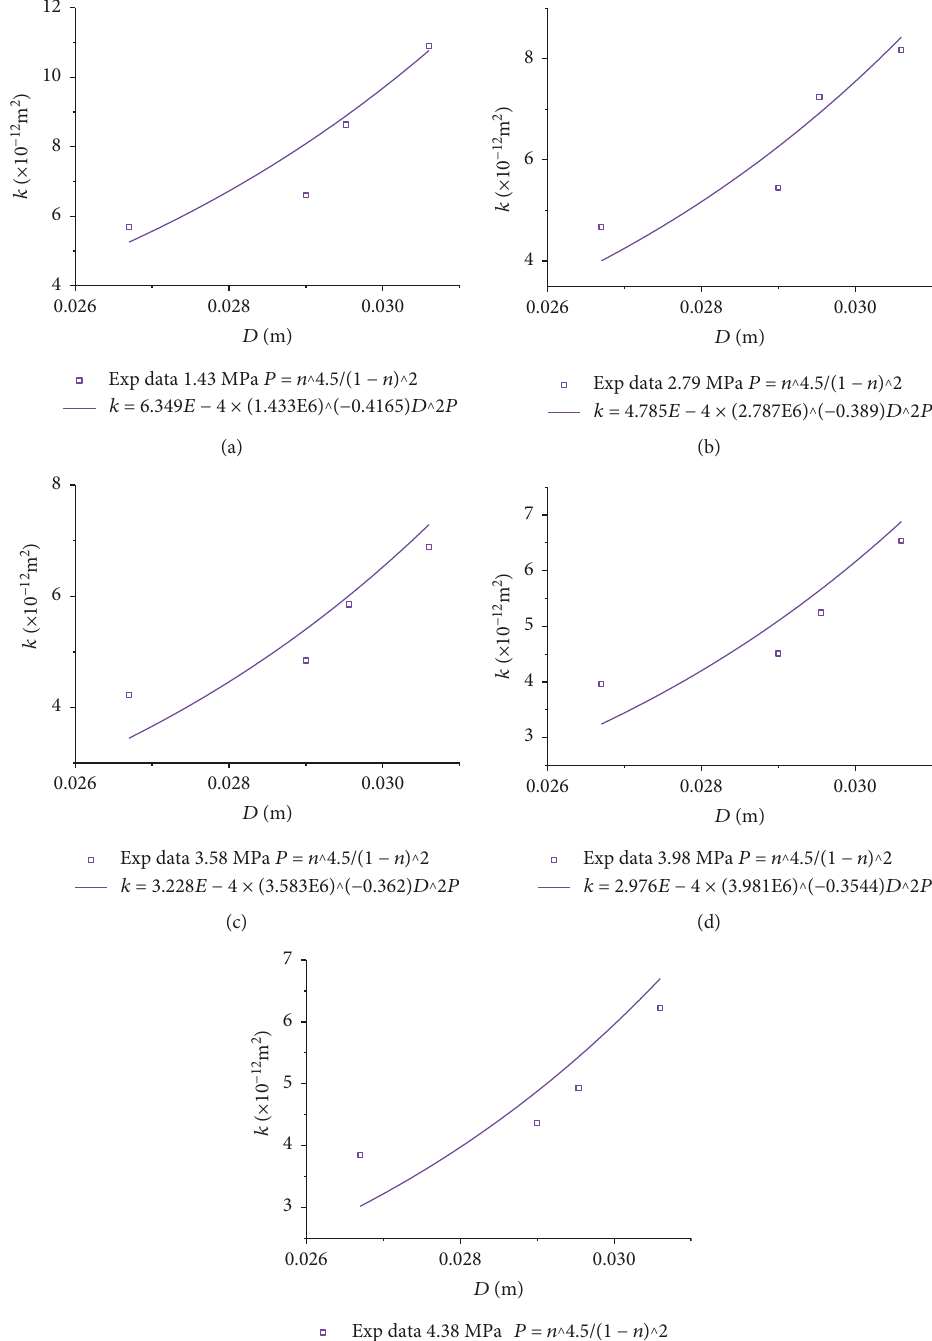
Figure 8: Intrinsic permeability characteristic with the in fl uence of particle size and initial porosity under di ff erent